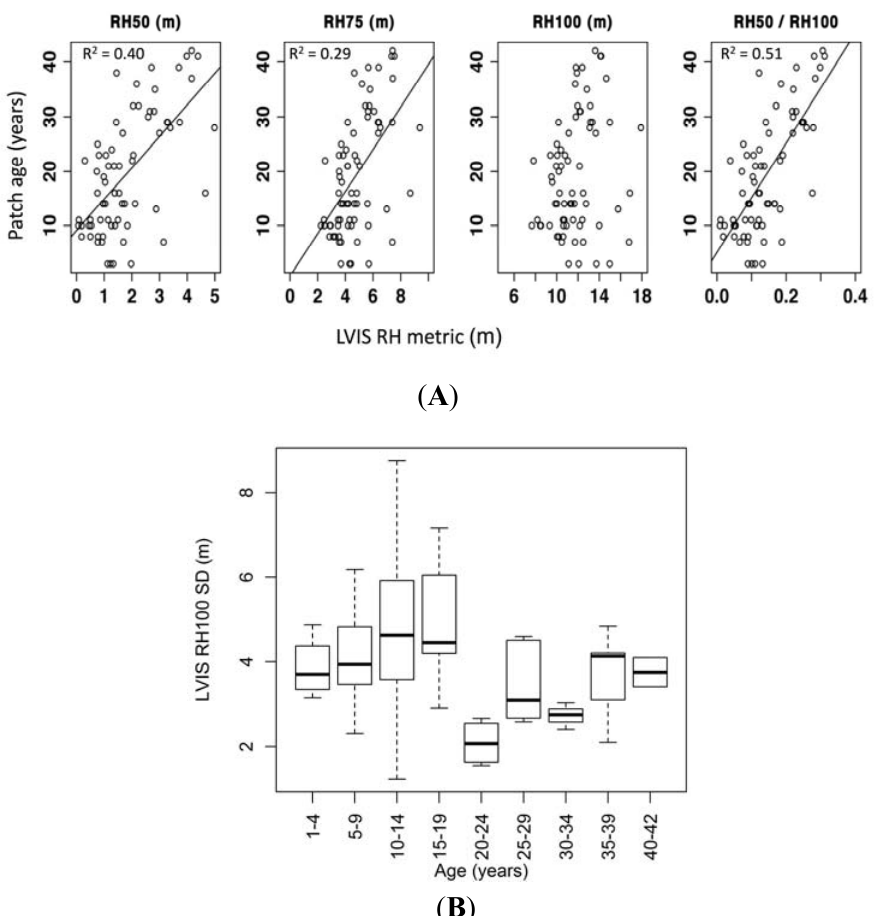
Figure 4. ( A ) Forest patch age modeled as a function of LVIS waveform metrics. Overlap with LVIS swath is >5 ha. Line fits are added to significant models (see Table 2 for model parameters). ( B ) Within-patch standard deviation in LVIS-derived canopy height (RH100), showing that mature (>20 years) stands are more homogeneous than young stands.